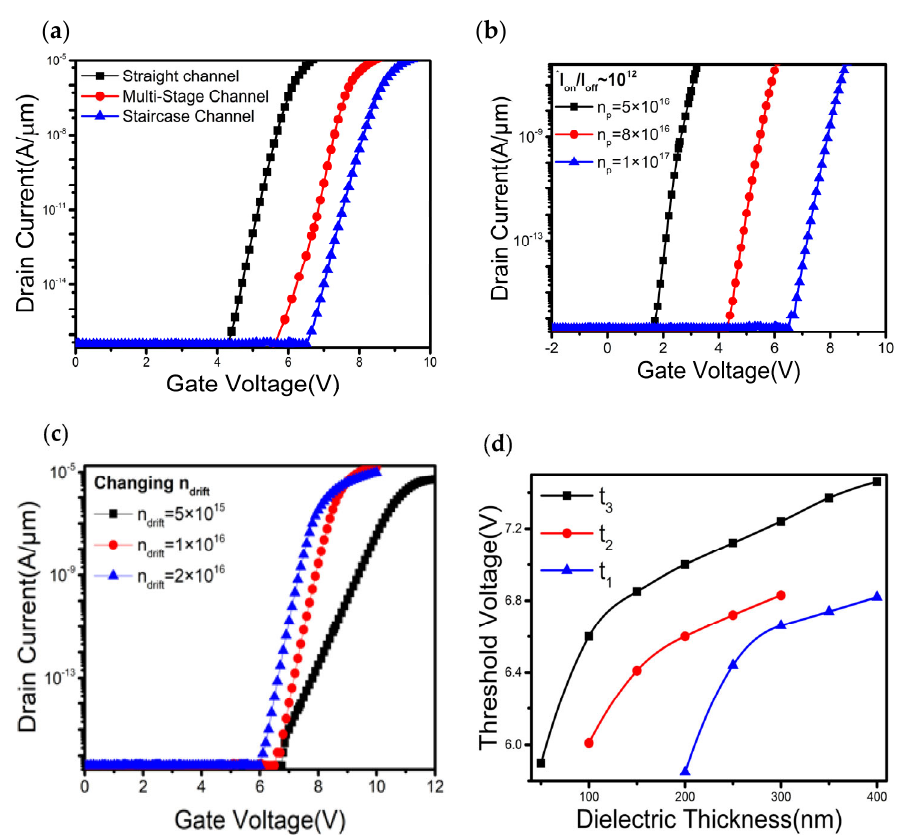
Figure 2. Transfer characteristics of the devices ( a ) Transfer curves of different types of vertical transistors with the same layer thickness and doping concentration. ( b ) Transfer curves of the staircase channel transistor at various n p . ( c ) Variation of transfer curves of the staircase channel transistor with n drift . For ( a – c ), the drain voltage for demonstrating transfer curves is 5V. ( d ) Variations of threshold voltage to the lateral dielectric layer (staircase) thickness.